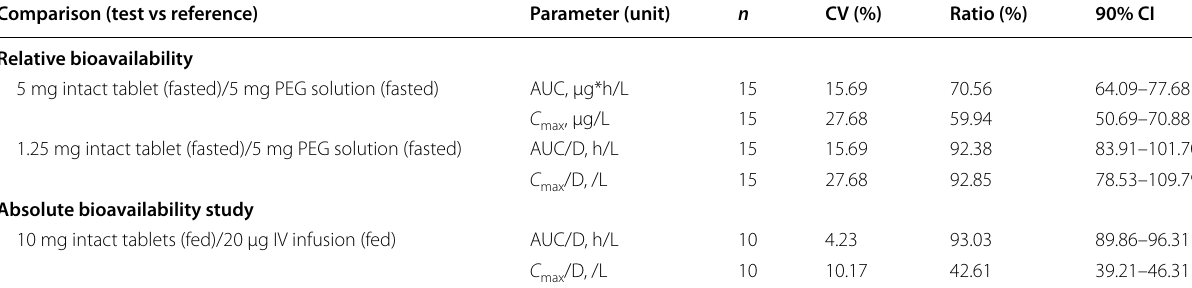
ANOVA Analysis of variance, AUC Area under curve, AUC/D Dose-normalized area under the curve, CI Confidence interval, C max Maximum plasma concentration, C max /D Dose-normalized maximum plasma concentration, CV Coefficient of variation, IV Intravenous, LS Least squares, PEG Polyethylene glycol Ratio: LS means for the respective treatment ratio calculated by ANOVA